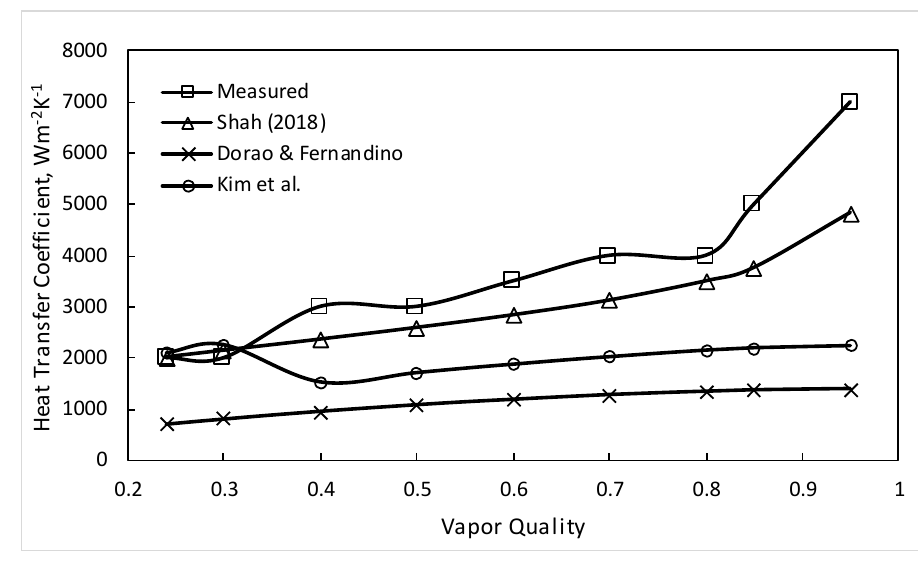
Figure 5. Data of Rahman et al. [30] in a rectangular channel compared to various correlations. D HYD = 0.81 mm, AR = 0.5, G = 50 kgm − 2 s − 1 , T SAT = 35 C.